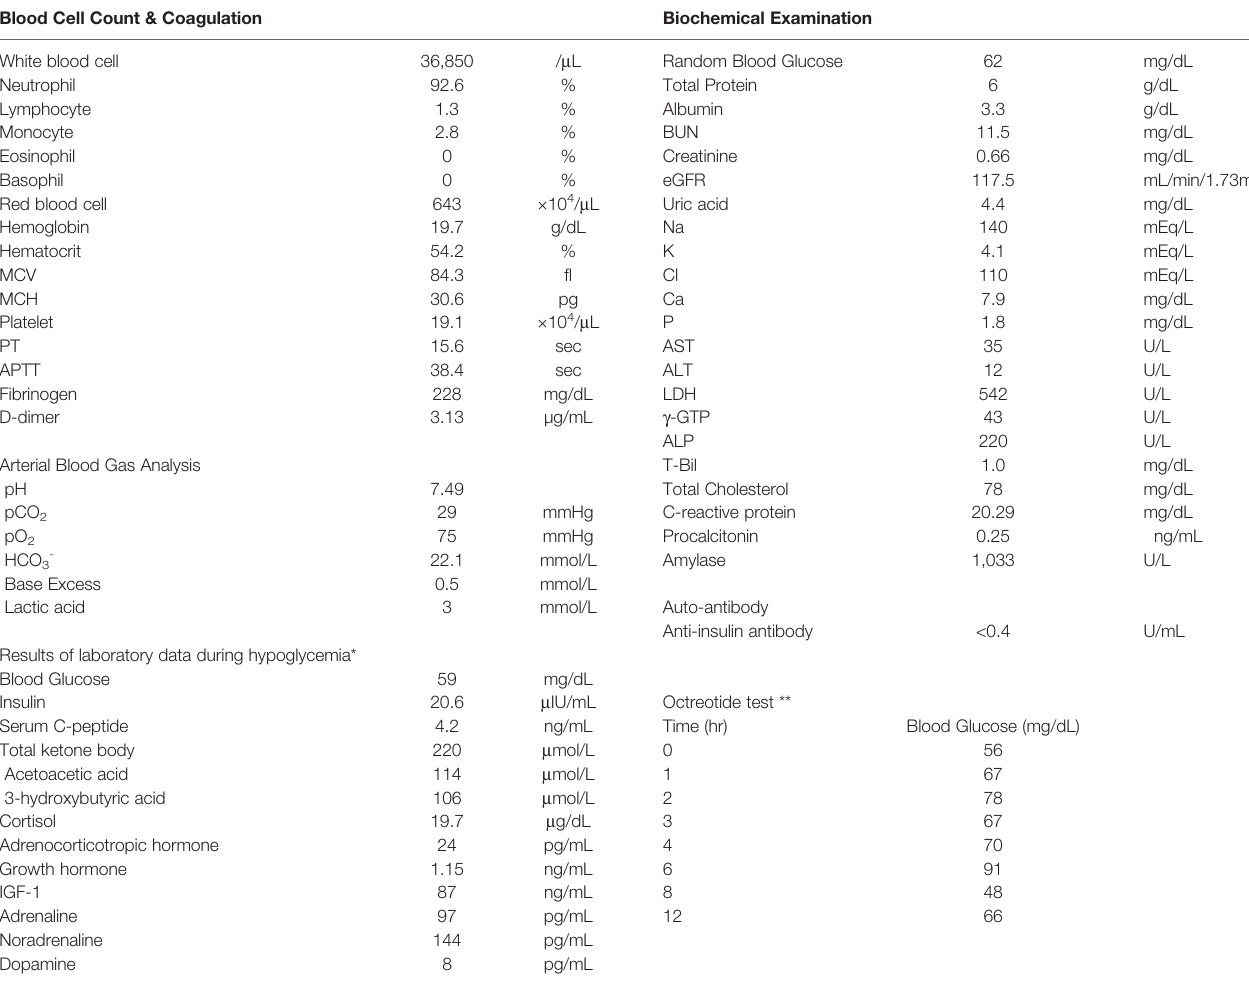
TABLE 1 | Laboratory